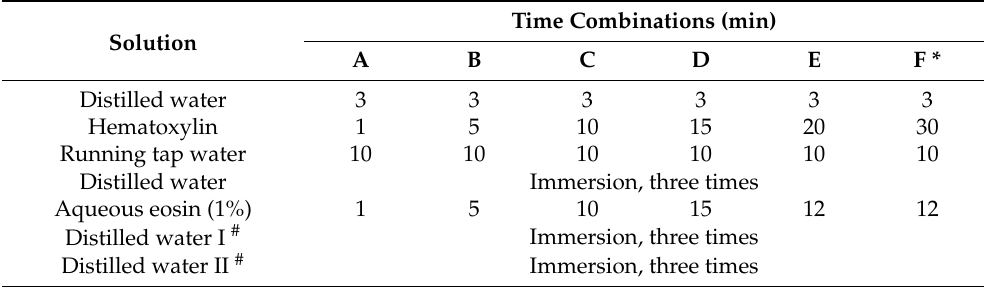
Table 7. H&E staining of sections in